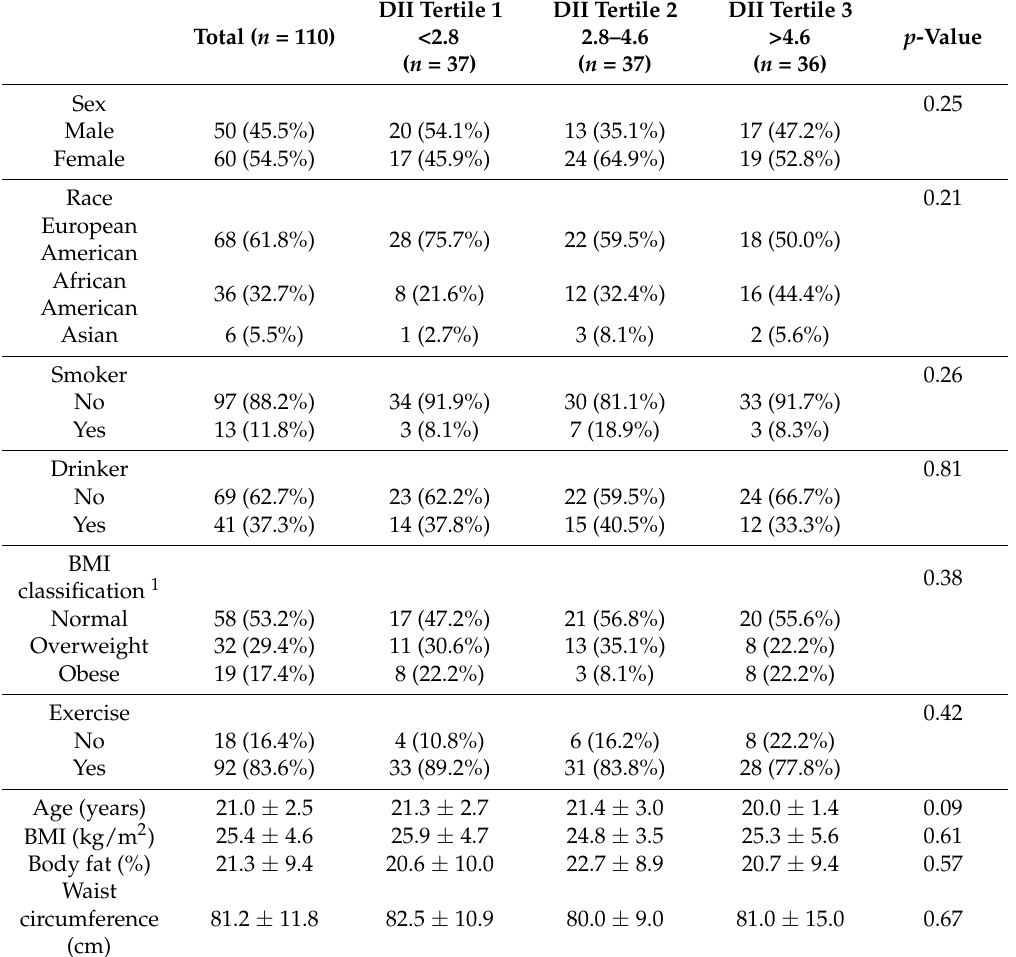
Table 1. Participants’ characteristics by Dietary Inflammatory Index (DII) tertiles.